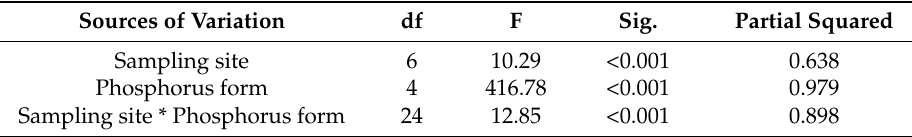
Table 3. Statistical results of two-way ANOVA on the content of each type of IP. Sources of